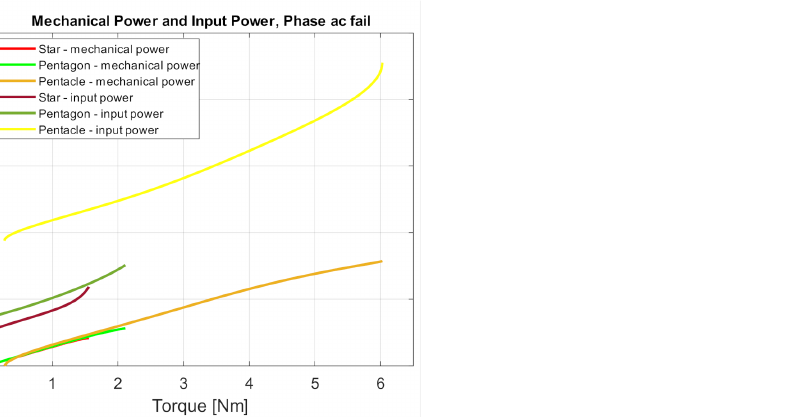
Figure 10. Power and power input depending on load torque, phase failure ac , U IN = 5 × 230 V, 50 Hz.